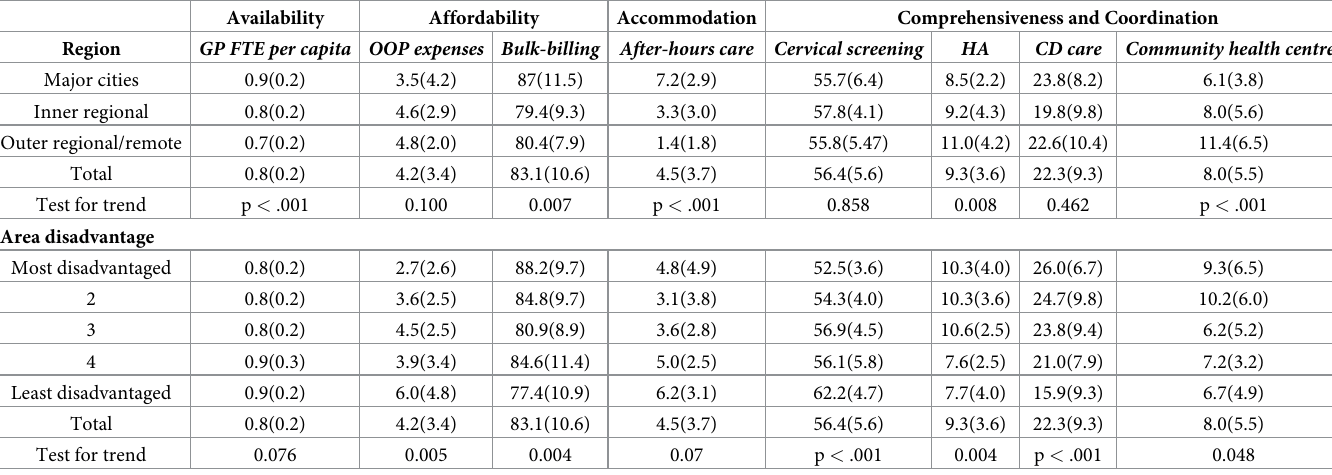
Table 2. Area PHC characteristics by region and area SE disadvantage, mean